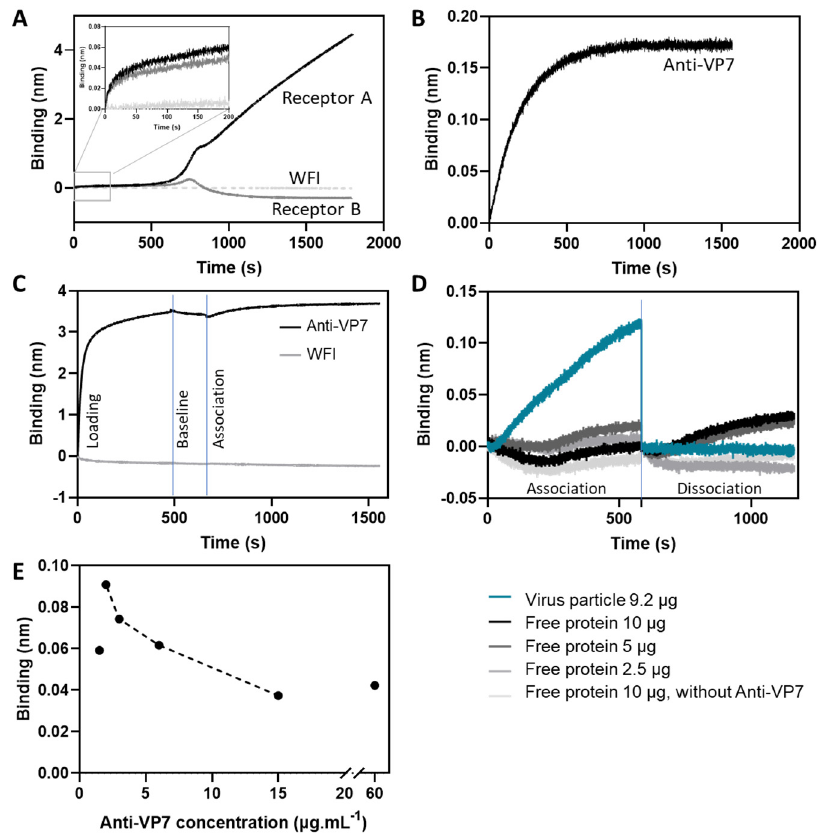
Figure 1. Rotavirus binding response to ( A ) glycoreceptors A and B (receptors’ concentration = 0.5 µ g · mL − 1 ) and naked streptavidin biosensors (WFI) (representative binding curve, n = 2) and ( B ) anti-VP7 antibody (representative binding curve, n = 3). Primary antibody was diluted to a final concentration of 15 µ g · mL − 1 . Rotavirus sample concentration was 17.6 µ g · mL − 1 (in experiments ( A – E )). ( C ) Evaluation of the specific binding of rotavirus particles to the primary antibody anti-VP7-coated protein A biosensor (black line) in comparison to naked protein A biosensors (grey line). ( D ) Evaluation of free VP7 protein binding. The binding and association profiles of free proteins (3 loads—darker greyscale lines) was compared to the rotavirus sample (9.2 µ g—blue line) and with free proteins to the naked biosensor (10 µ g—light grey line). Both association and dissociation steps were aligned to 0. ( E ) Antibody titer: different antibody concentrations (ranging from 1.5 to 60 µ g · mL − 1 ) were evaluated to optimize the binding response (n = 1). Dashed line: concentrations where binding is concentration